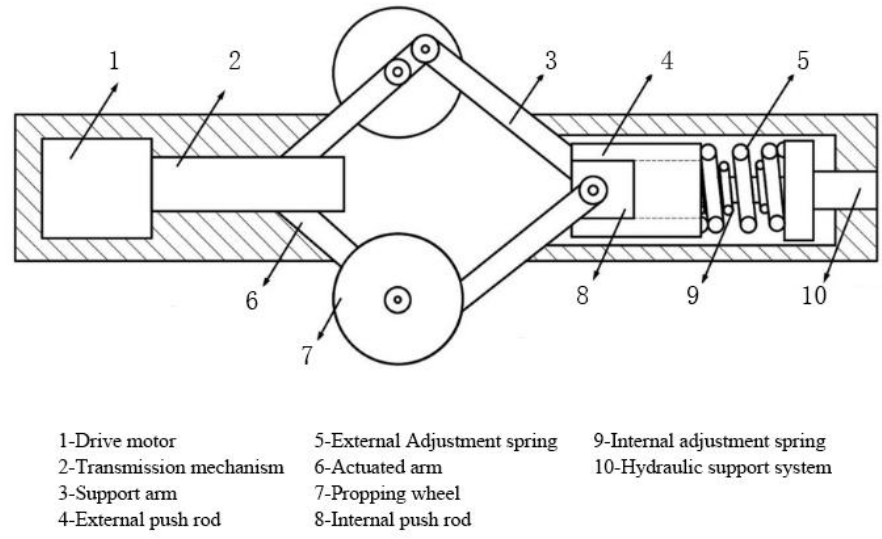
Figure 3. Structures of double push rod − double spring support adjustment mechanism.